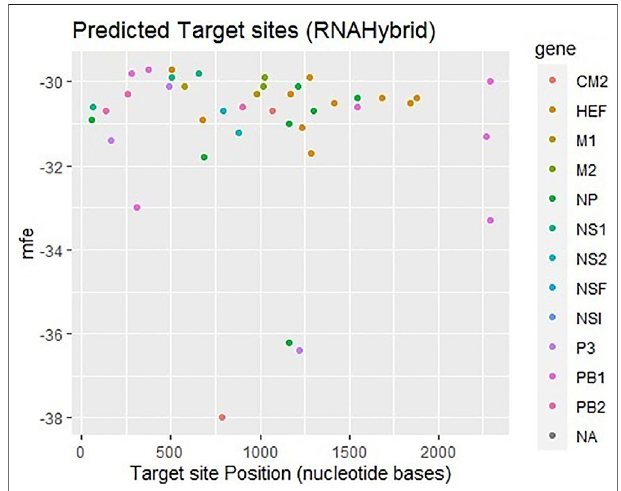
FIGURE 5 | Target sites of human miRNAs in genome of in fl uenza C virus predicted by RNAhybrid server. The color key represents the respective genes in the graph. The gray dots labeled as NA which indicate non- applicable.